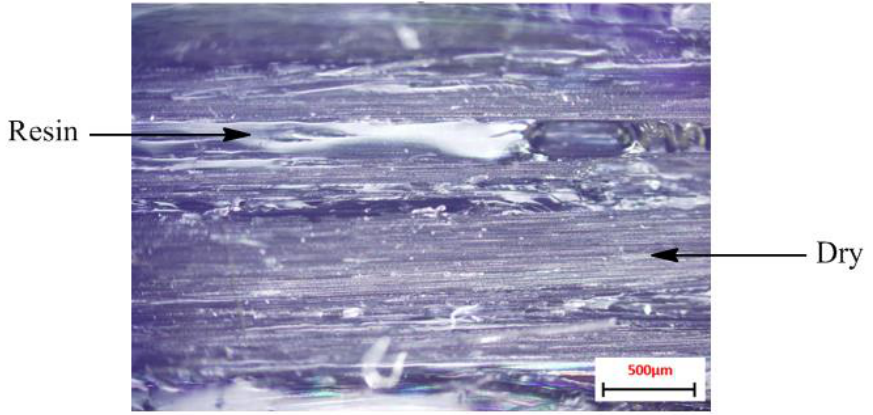
Figure 6. Optical microscope image of dry fibers for sample with central tow splitting.